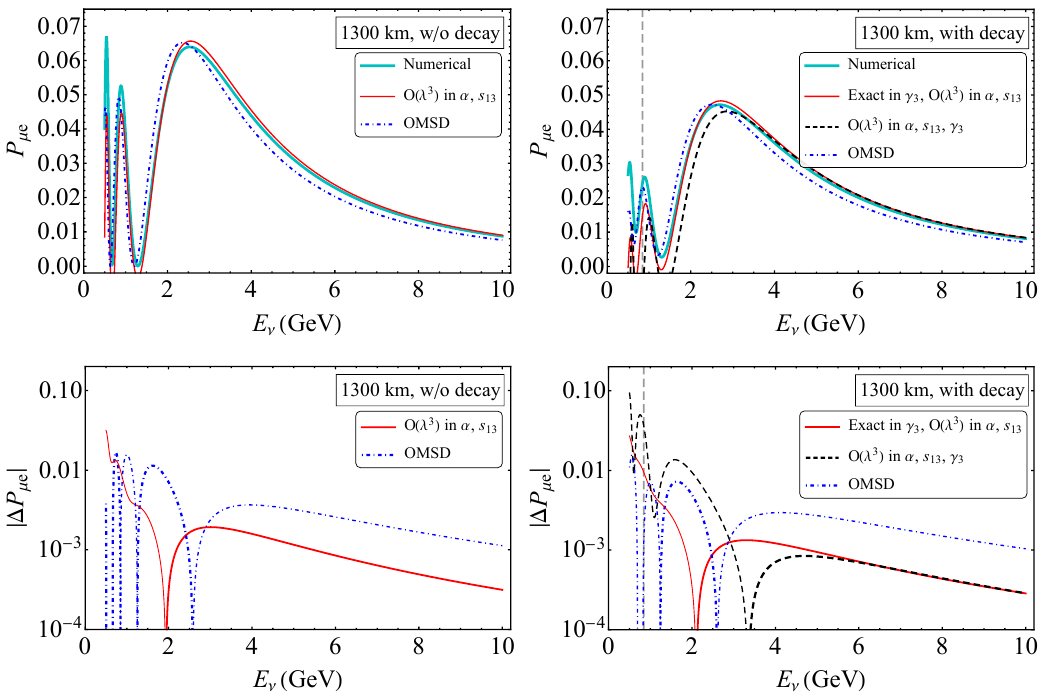
Figure 2 . The top panels show probabilities P µe in the scenarios without (left) and with (right) decay, for L = 1300 km and γ = 0 . 1 . The bottom panels show the absolute error | ∆ P 3 analytic expressions shown. The thick (thin) curves indicate positive (negative) signs of ∆ P dashed gray vertical line follows the same convention as that mentioned in figure